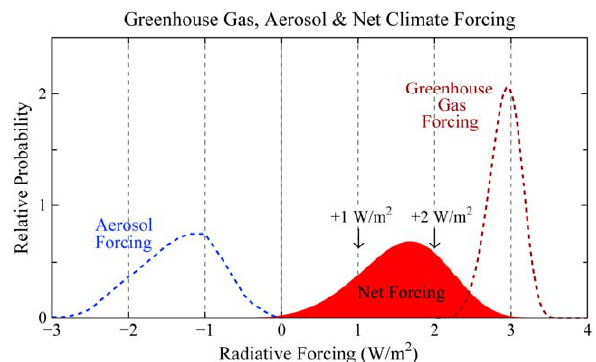
Fig. 1. Climate forcings employed in this paper. Forcings through 2003 (vertical line) are the same as used by Hansen et al. (2007), except the tropospheric aerosol forcing after 1990 is approximated as -0.5 times the GHG forcing. Aerosol forcing includes all aerosol effects, including indirect effects on clouds and snow albedo. GHGs include O 3 and stratospheric H 2 O, in addition to well-mixed GHGs.These data are available at http://www.columbia.edu/~mhs119/EnergyImbalance/Imbalance.Fig01.txt